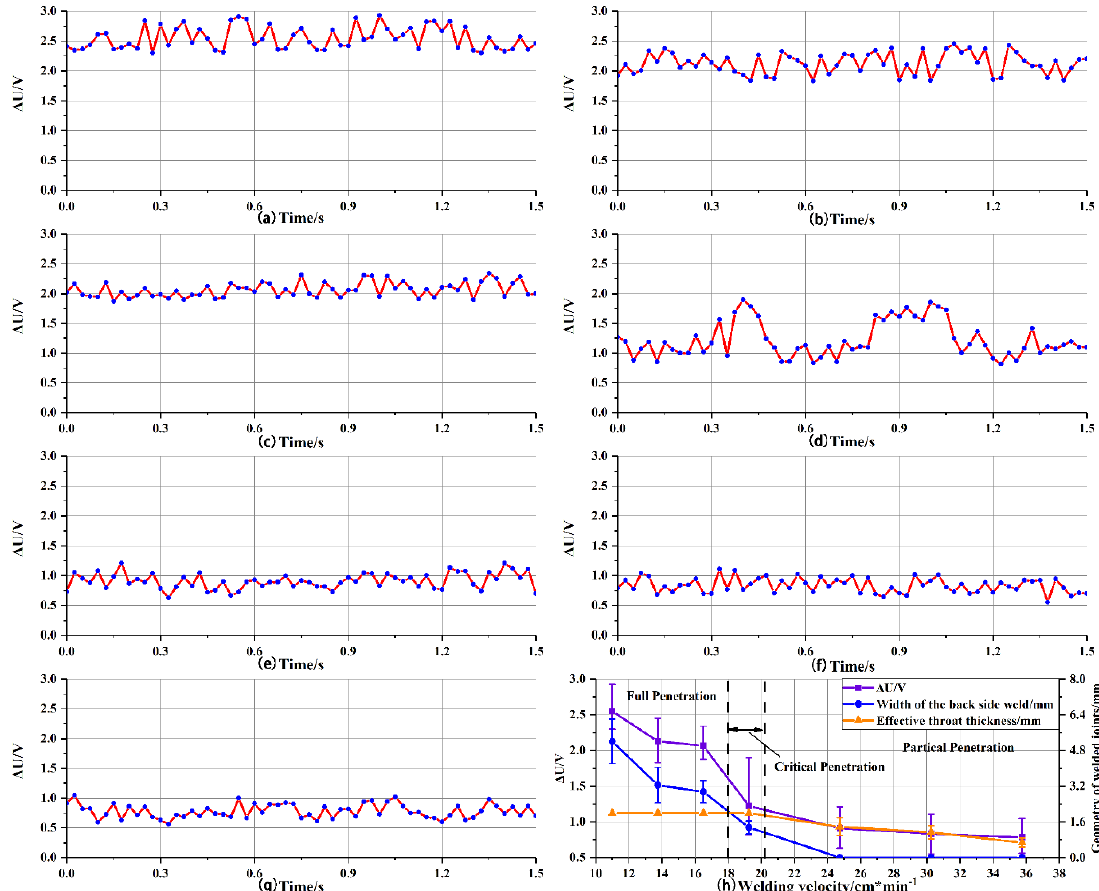
Figure 15. ΔU with arc burning time at different penetration status. Full penetration: ( a ) V = 11 Figure 15. ∆ U with arc burning time at di ff erent penetration status. Full penetration: ( a ) V = 11 cm / min; cm/min; ( b ) V = 13.75 cm/min; ( c ) V = 16.5 cm/min. Critical penetration: ( d ) V = 19.25 cm/min. Full ( b ) V = 13.75 cm / min; ( c ) V = 16.5 cm / min. Critical penetration: ( d ) V = 19.25 cm / min. Full penetration: penetration: ( e ) V = 24.75 cm/min; ( f ) V = 30.25 cm/min; ( g ) V = 35.75 cm/min; ( h ) the relationship ( e ) V = 24.75 cm / min; ( f ) V = 30.25 cm / min; ( g ) V = 35.75 cm / min; ( h ) the relationship between ∆ U and between ΔU and geometry of the weld joints. geometry of the weld